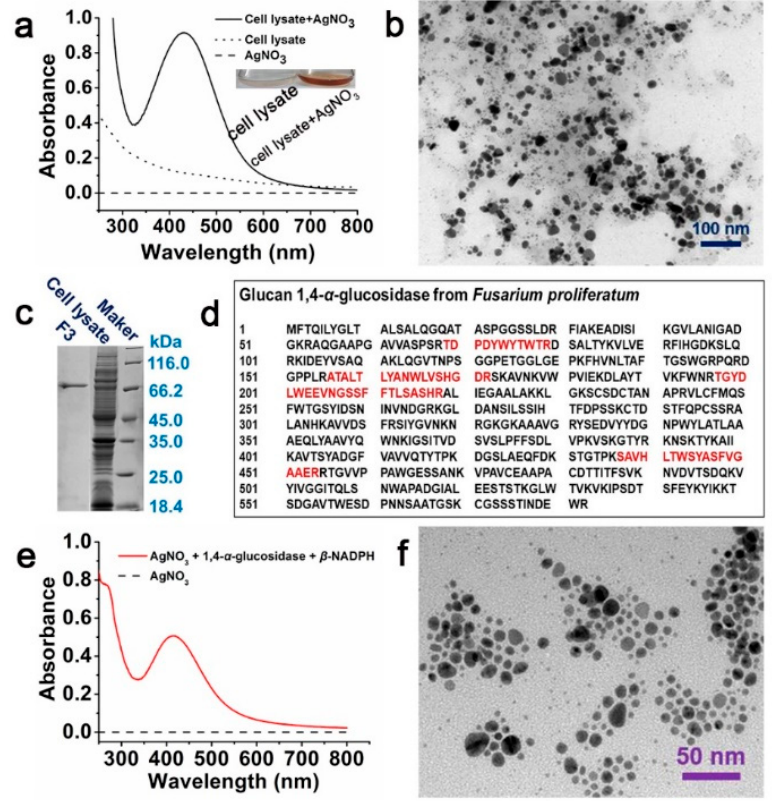
Figure 1. ( a ) Color change and UV-Vis spectra of AgNPs synthesized in cell lysate; ( b ) TEM image of AgNPs synthesized in cell lysate; ( c ) SDS-PAGE analysis of purified protein from F3; ( d ) database matching of the sequenced peptide. The protein was identified as 1,4- α -glucosidase of F. proliferatum by matching the sequenced peptide with protein databases (NCBIprot). The peptide (in red) in 1,4- α -glucosidase is completely matched to the peptide in the 72.8 kDa protein; ( e ) UV-Vis spectra of AgNPs synthesized by purified enzyme from cell lysate; ( f ) TEM image of AgNPs synthesized by purified enzyme from F3.